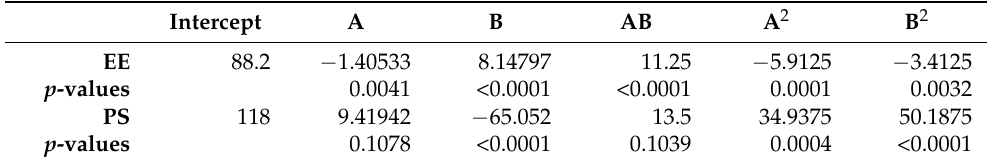
Table 4. Analysis of variance (ANOVA)